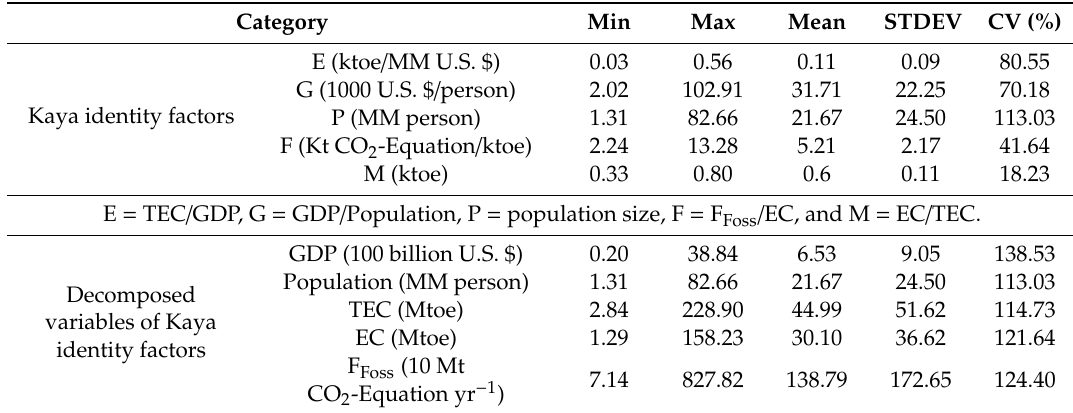
Table 1. Descriptive statistics for fossil fuel CO 2 flux in CO 2 equivalents (F Foss) , five factors of the Kaya identity (E, G, P, F, and M), and the corresponding decomposed variables for 30 European countries from 2010 to